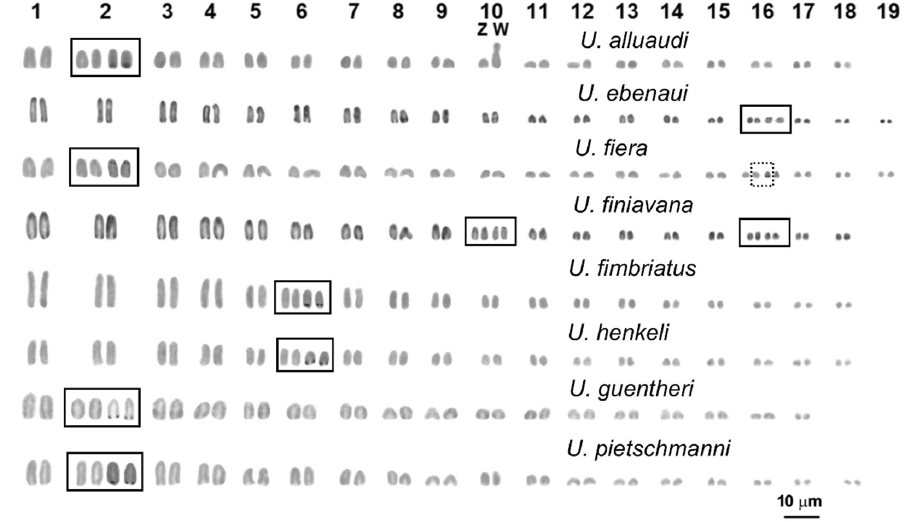
Figure 3. Karyotype of U. alluaudi sequentially stained with C-banding + Giemsa ( A ), + CMA 3 ( B ) and + DAPI ( C ). 4. Discussion Our cytogenetic analysis provided the first karyotype description of eight Malagasy gecko species of Uroplatus and represents the first step in describing the karyological var- iability of the genus, as well as a new contribution to reconstruct chromosomal evolution- ary dynamics in a larger clade of leaf-toed geckos.